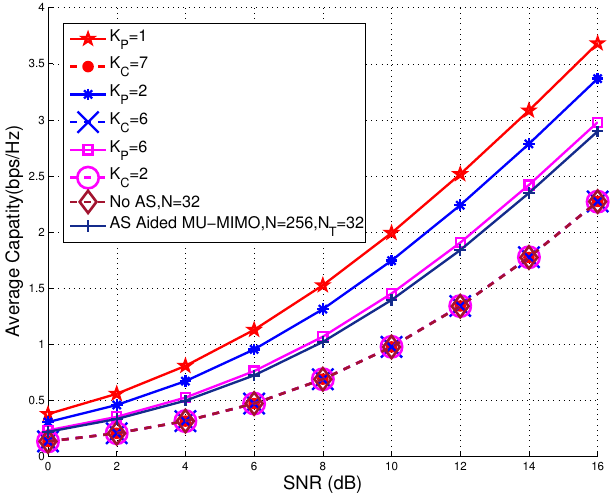
Figure 6. Achievable capacity performance of proposed UOSTxAS system associated with K = 8 active users, N = 256 antennas, N T = 32 transmit RF chains, and various number of PUs and CUs, in comparison to that of conventional MU-MIMO without AS and AS aided MU-MIMO